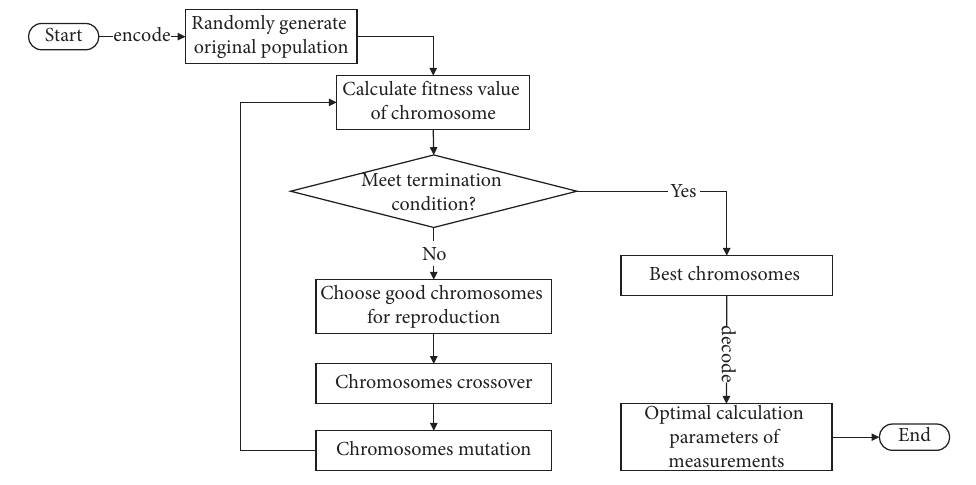
Figure 5: The flow chart of